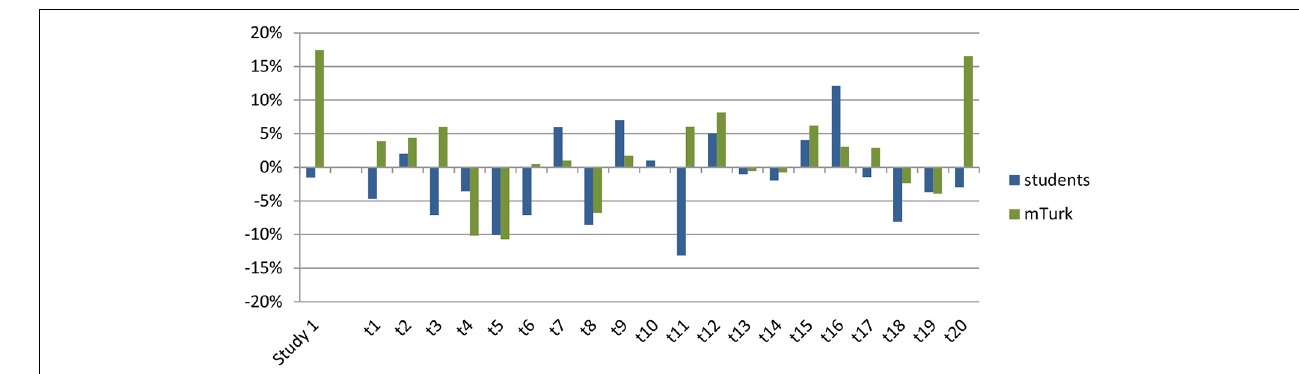
FIGURE 8 | Size of the diagnosticity effect for each individual trial (on the x-axis) for the students (in blue, studies 1a and 2a) and mTurk (in green, studies 1b and 2b) samples.